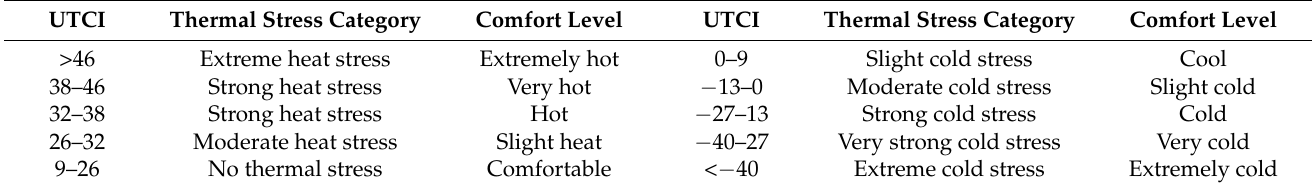
Table 1. Classification standard of thermal comfort based on